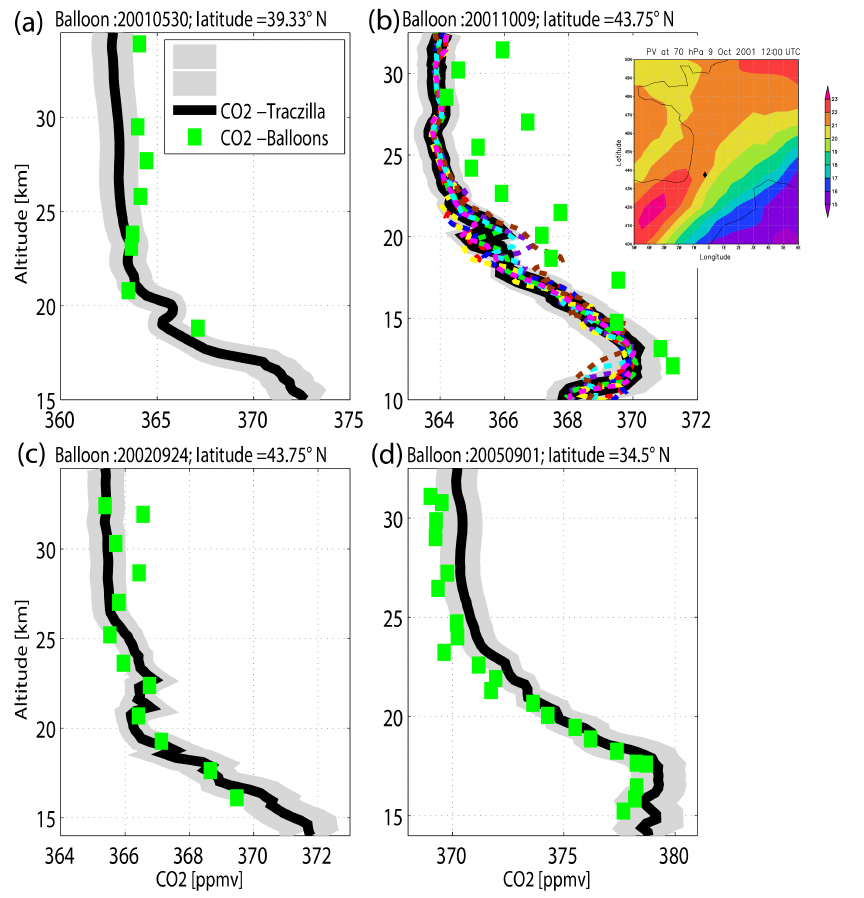
Figure 4. Reconstructed vertical profiles of the monthly mean CO 2 compared with each in situ stratospheric balloon observation of CO 2 (Engel et al., 2009). Black curves show reconstructed vertical profiles of mean CO 2 . Green squares show in situ balloon measurements of mean CO 2 . Grey shading shows the 95% confidence interval from the reconstruction. The measurements were taken from Sanriku, Japan (39.33 ◦ N), on 30 May 2001 (a) ; Aire sur l’Adour, France (43.75 ◦ N), on 9 October 2001 (b) and on 24 September 2002 (c) ; and Fort Sumner, New Mexico, USA (34.5 ◦ N), on 1 September 2005 (d) , respectively. The different dashed lines show the other eight reconstructed profiles surrounding the measurement on 9 October 2001. The insert on the upper right panel shows the potential vorticity (in PVU) on the 70hPa surface for 9 October 2001 at 12:00UTC over France from ERA-Interim. The location of Aire sur l’Adour is indicated by a